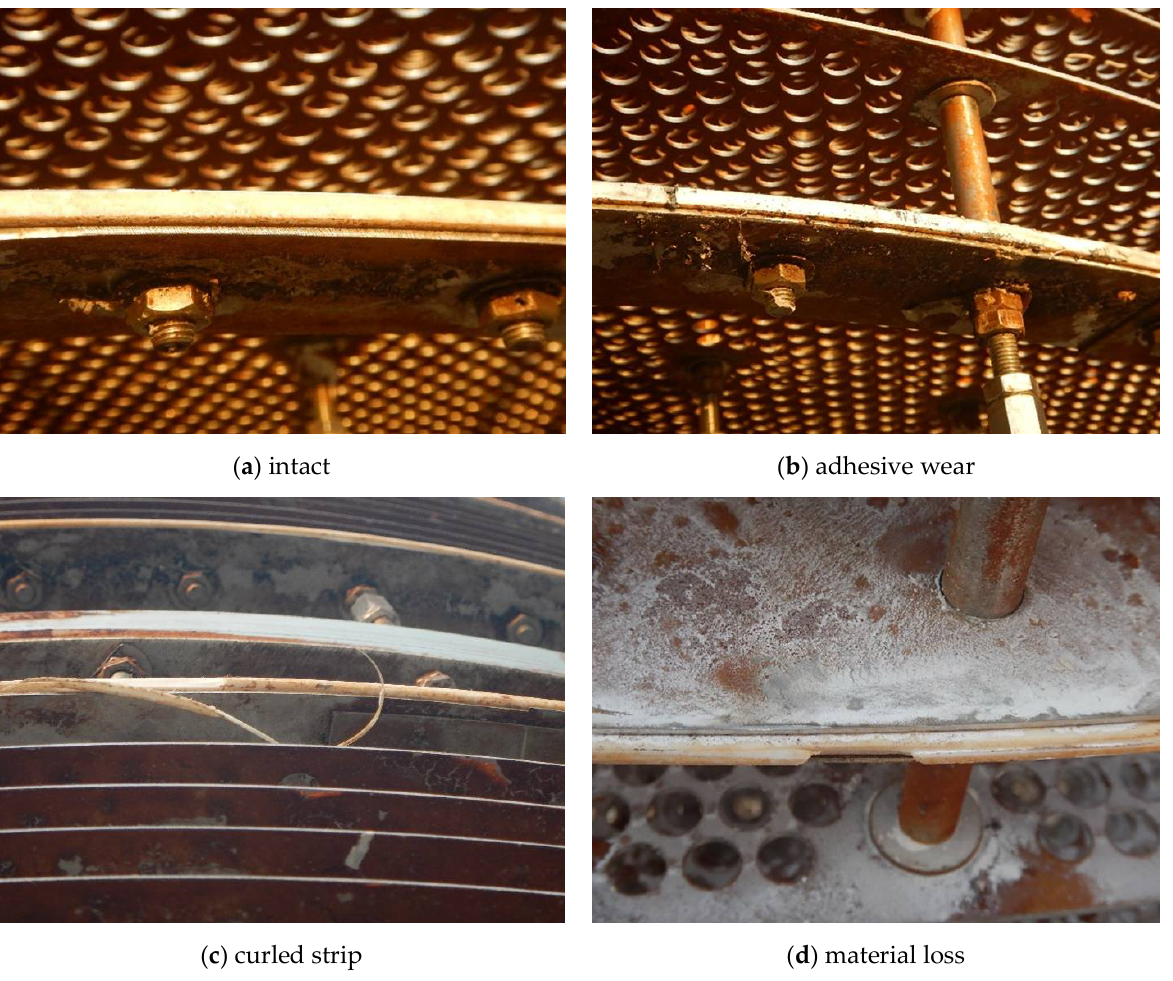
Figure 8. Diverse wear morphologies on the PTFE baffles.